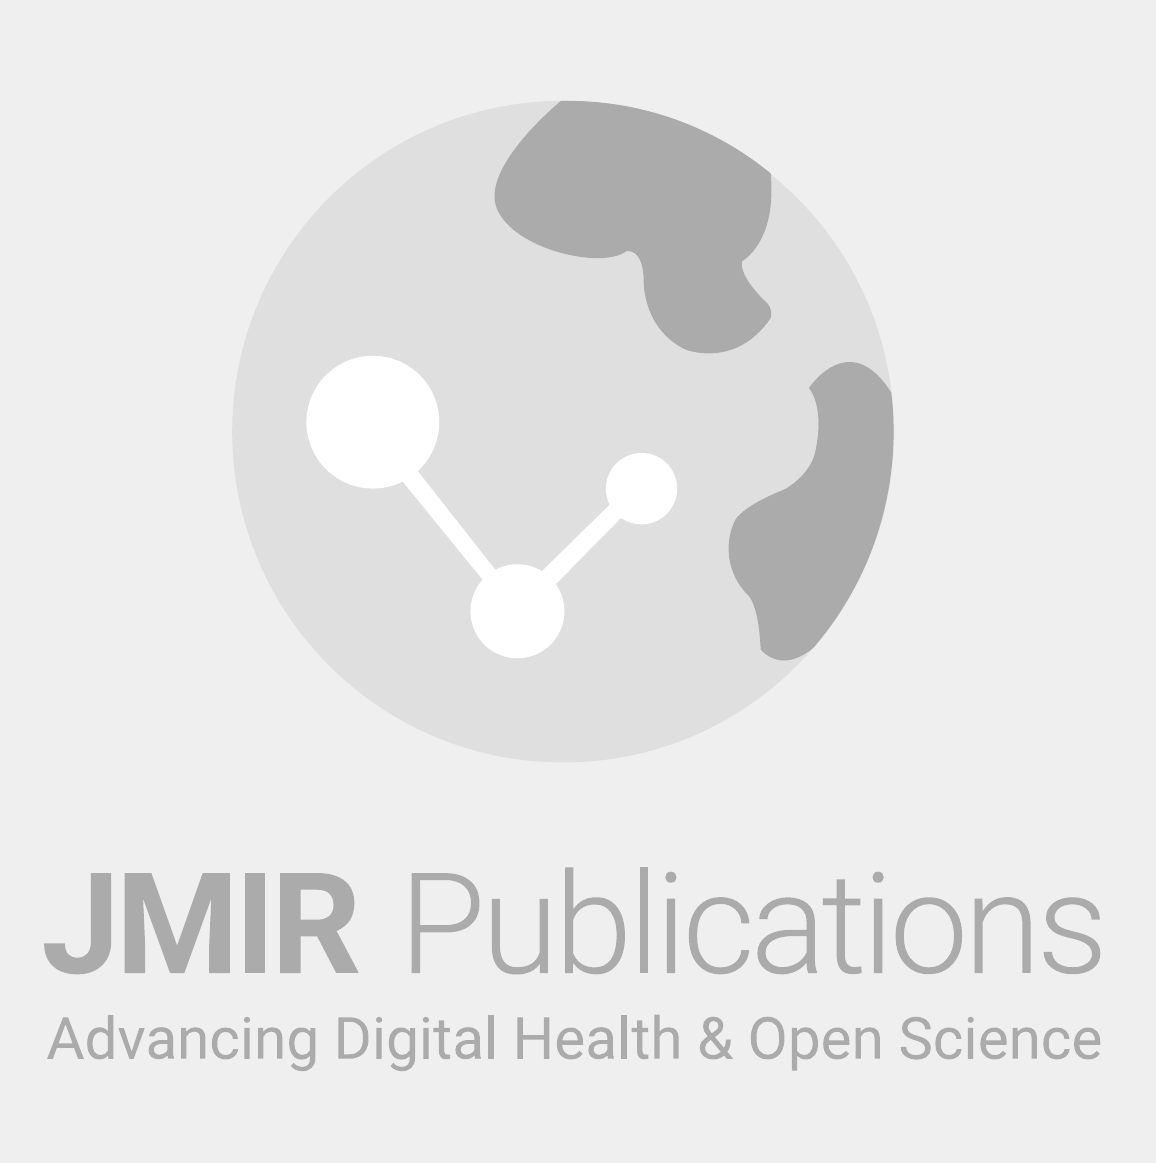
Figure 3. Screenshot of the ResTraxx Data Center website, showing the compliance tab with sample compliance and efficacy data for one month of CPAP use for a hypothetical patient. The thresholds specified on another tab allow for color-coding of efficacy and compliance data — this color-coding allows for quick review of how well any one patient is doing on CPAP. Specific data values are also provided, which can aid clinical management. The symbol legend at the bottom of the tab explains the meaning of each symbol used in this tab (see also Table